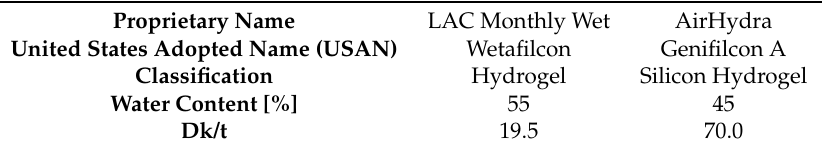
Table 1. Main characteristics of contact lenses (CLs).